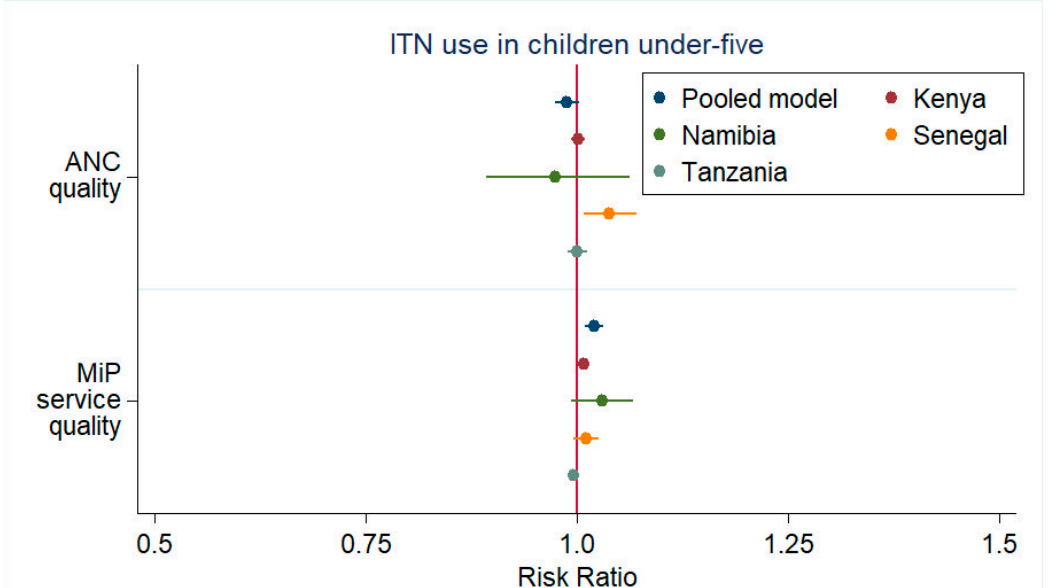
Figure 4. Forest plots of adjusted associations of malaria in pregnancy and antenatal care quality with each of three study outcomes. Abbreviations: IPTp-2—intermittent preventive treatment in pregnancy—2 doses; ITN—insecticide-treated bed net; ANC—antenatal care; MiP—malaria in pregnancy.